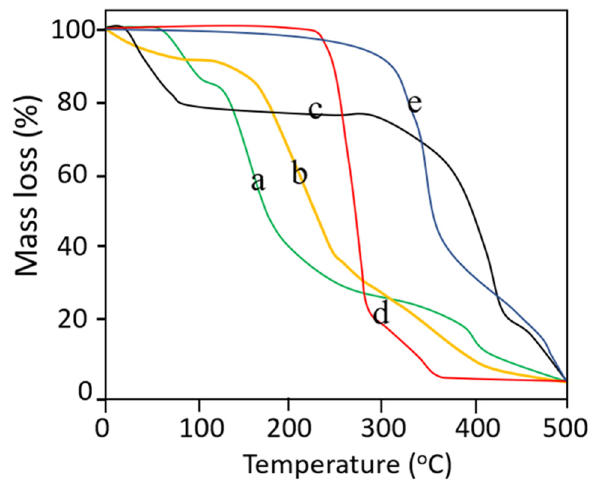
Figure 7. TGA thermograms of ( a ) PVA, ( b ) Thiolated Chitosan, ( c ) PVP, ( d ) Simvastatin and ( e ) Dissolvable microneedle patch.